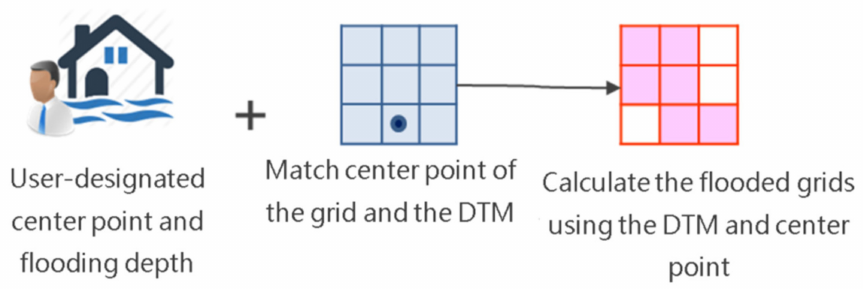
Figure 3. A depiction of the flooded grids